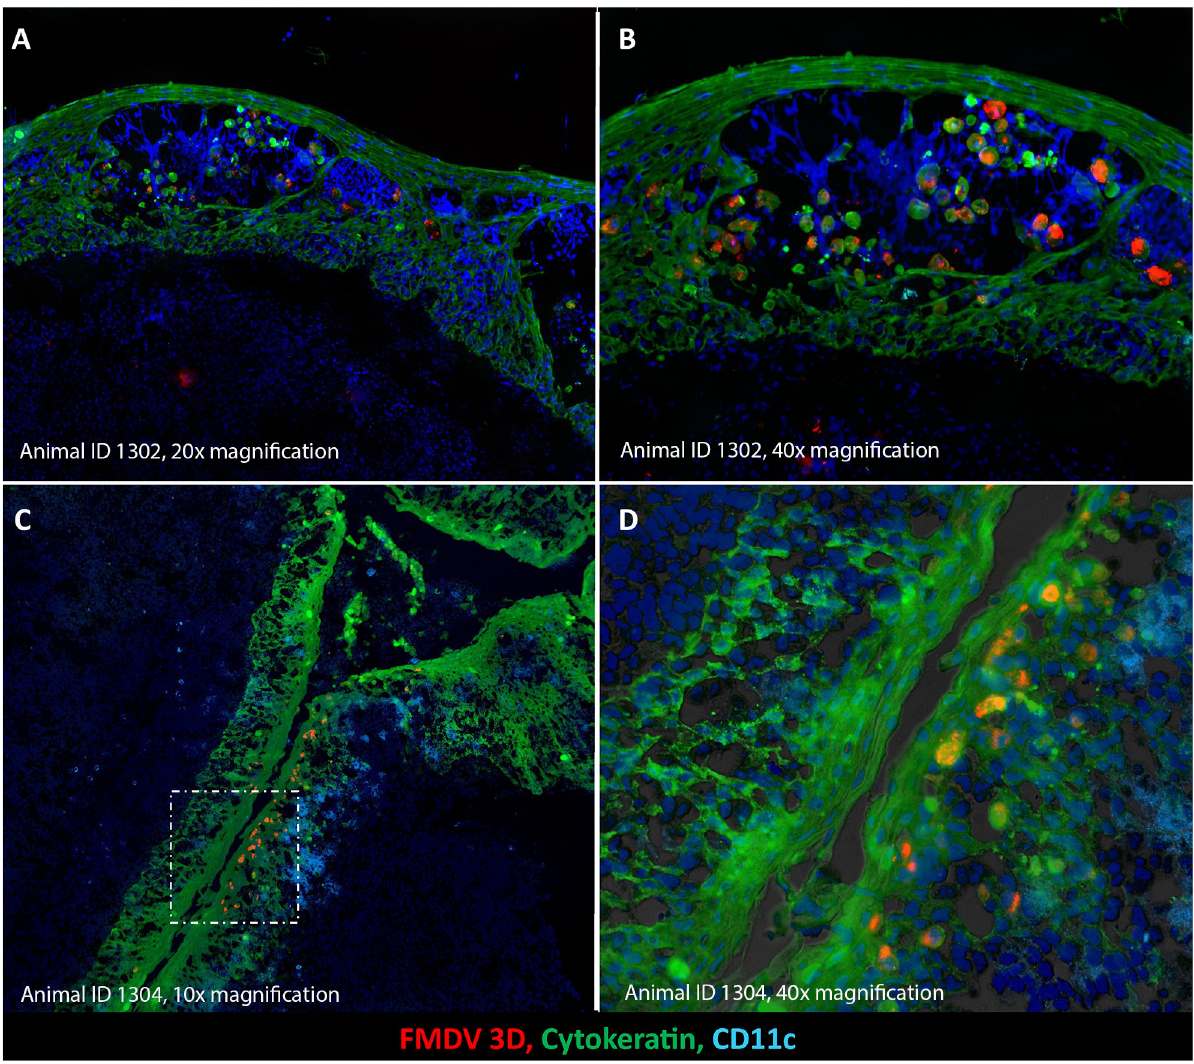
Fig 2. FMDV infection of paraepiglottic- and palatine tonsils of sheep during early stages of disease in INP-inoculated sheep. A-B) Primary FMDV infection of the paraepiglottic tonsil at 24 hours post intra-nasopharyngeal inoculation (animal ID 1301). A microvesicle within the surface epithelium of the tonsil contains large quantities of acantholytic, FMDV 3D/cytokeratin double-positive epithelial cells. A = 20x magnification, B = 40x magnification. C-D) FMDV-replication in an epithelial crypt of the ovine palatine tonsil at 48 hours post intra-nasopharyngeal inoculation (animal ID 1304). Large quantities of FMDV 3D (red) are present within structurally intact, cytokeratin+ (green) epithelial cells within the tonsil crypt. C = 10x magnification. D = 40x magnification with differential interference